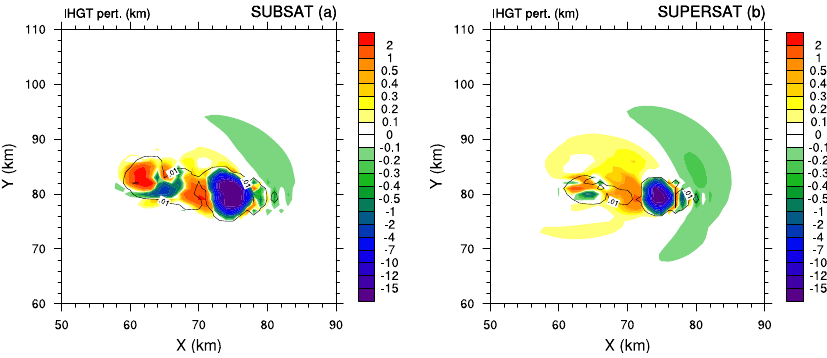
Fig. 5. Horizontal cross-section of IHGT tracer perturbation at 18km, at t = 40min for (a) SUBSAT and (b) SUPERSAT. The black line represents the total cloud mixing ratio contour of 0.01gkg − 1 (marking the cloud